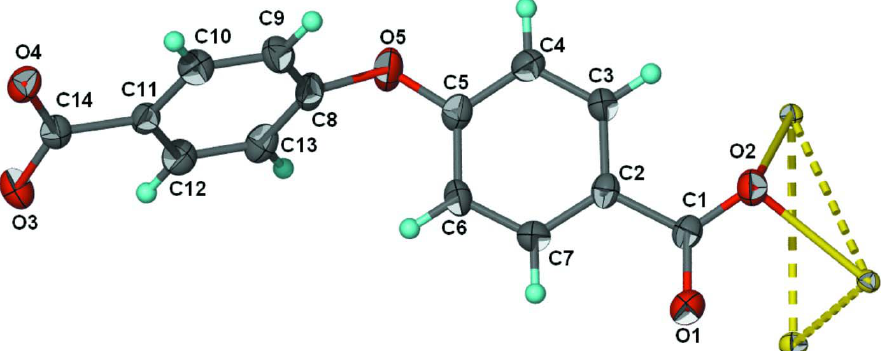
Thermal ellipsoid plot (Barbour, 2001) of the asymmetric unit of the title compound; displac ement ellipsoids are set at the 70% probability level. Hydrogeatoms are drawn as spheres of arbitrary radius. The two sodium atoms are disordered over three positions. Dashed lines denote the distances between